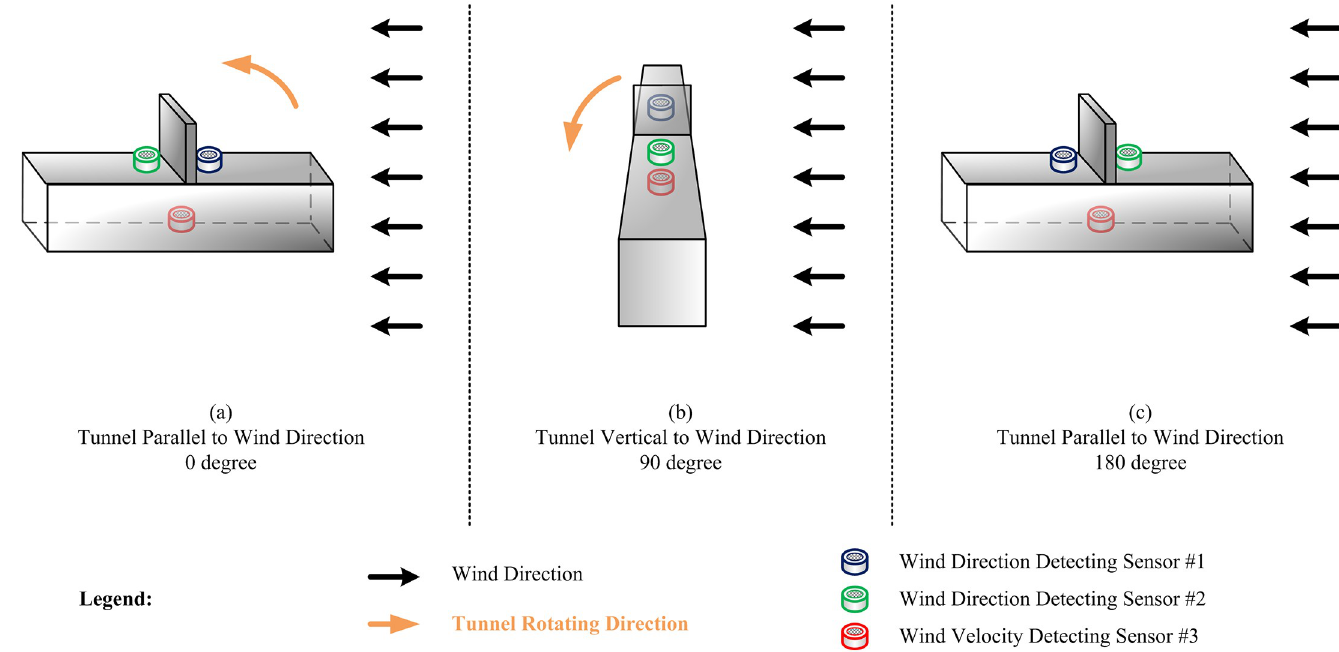
Fig 10. Complete wind velocity and wind direction measurement process.